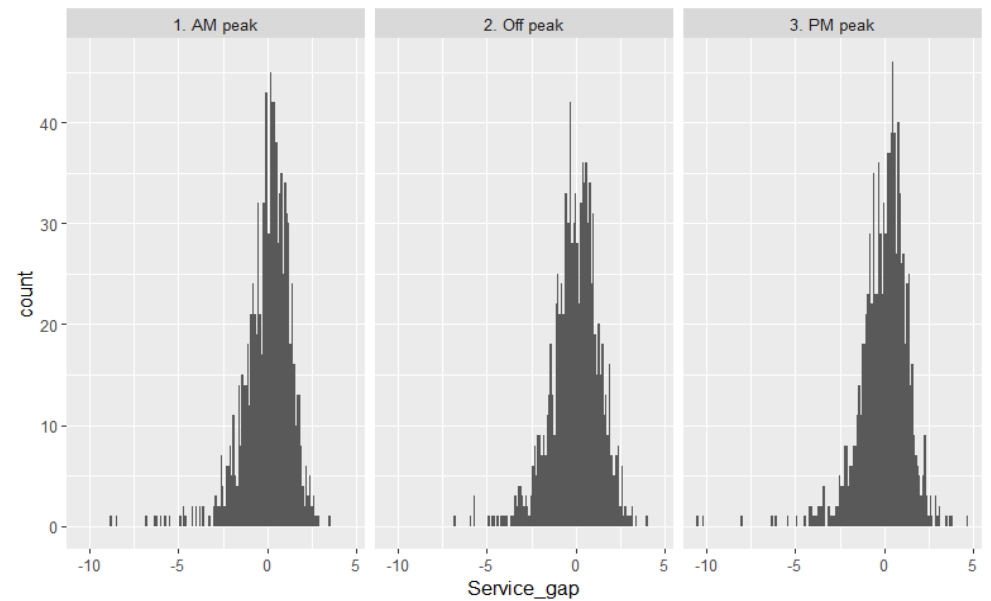
Figure 5. Histogram of service gap by time